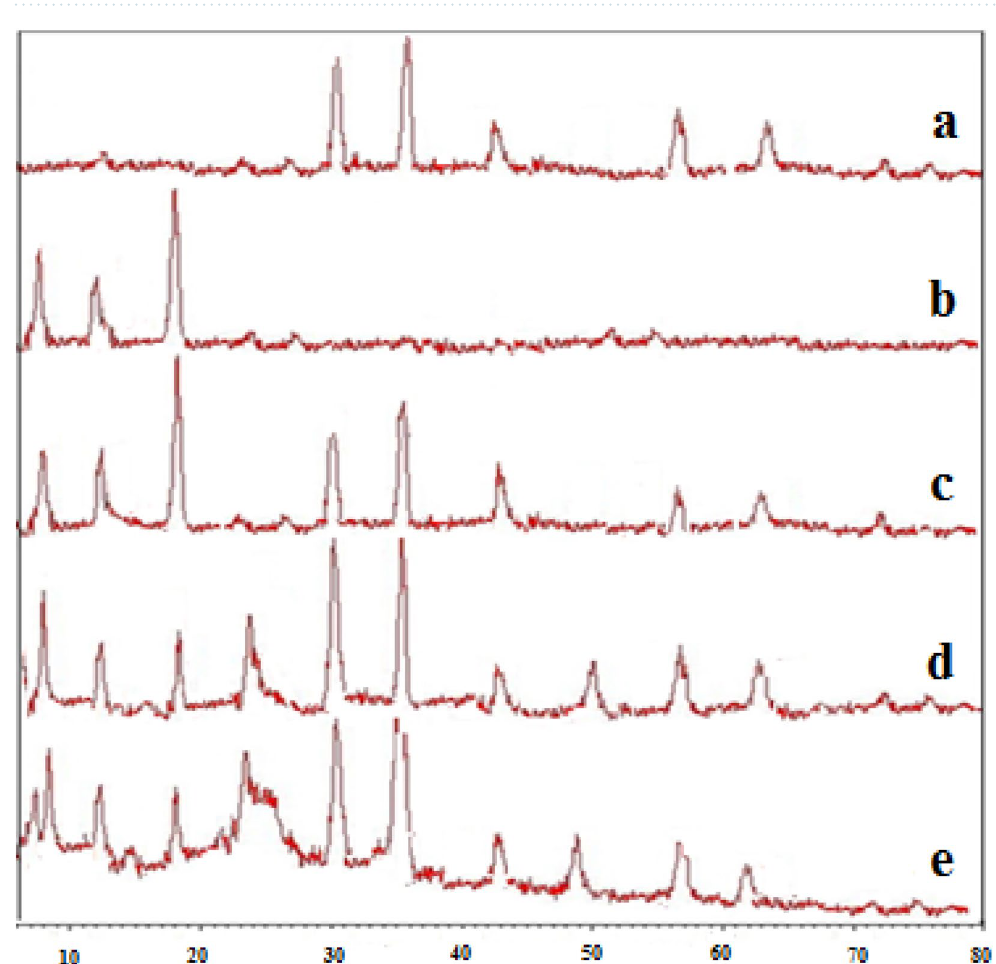
Figure 10. XRD patterns of MgFe 2 O 4 (a) , ZIF-8 (b) , ZIF-8/MgFe 2 O 4 (c) , ZIF-8/GO/MgFe 2 O 4 (d) , and ZIF-8/ MgFe 2 O 4 /GO/TC (e)